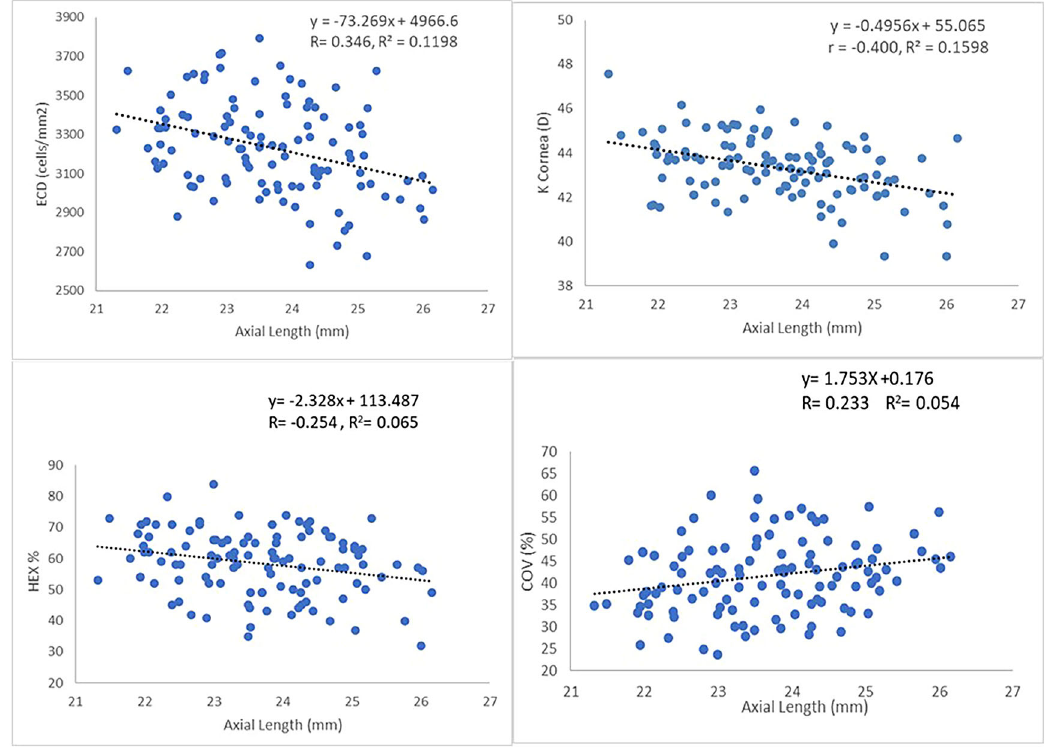
Figure 1. Relationship between ECD, HEX, COV, K and AL. ECD endothelial cell density , HEX hexagonality , COV coefficient of variation , K cornea curvature and AL axial